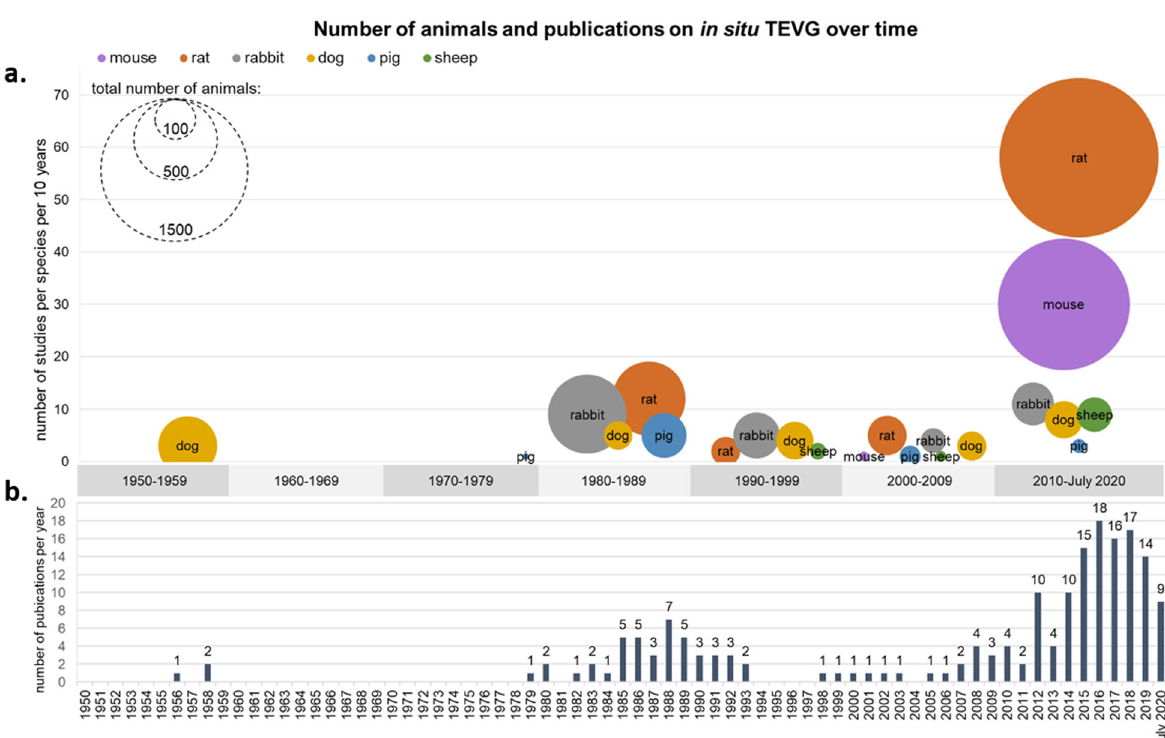
Fig. 2 Number of animals and publications on in situ TEVG. a Number of studies and number of animals per species combined per decade. Size of the dot represents total number of animal used (total number of animals per publication, e.g., in situ TEVG and control grafts), location of the dot on y -axis represents total number of studies published per decade per species. b Number of publications on animal studies of in situ TEVG per publication year. Abbreviations: TEVG Tissue Engineered Vascular